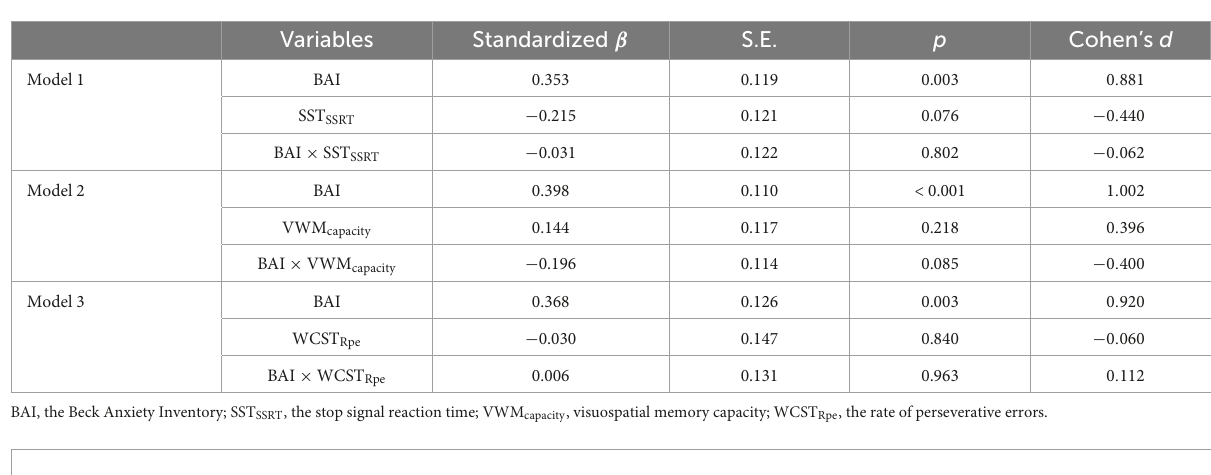
TABLE 4 The moderating effect of executive function on anxiety and general compulsion symptoms.